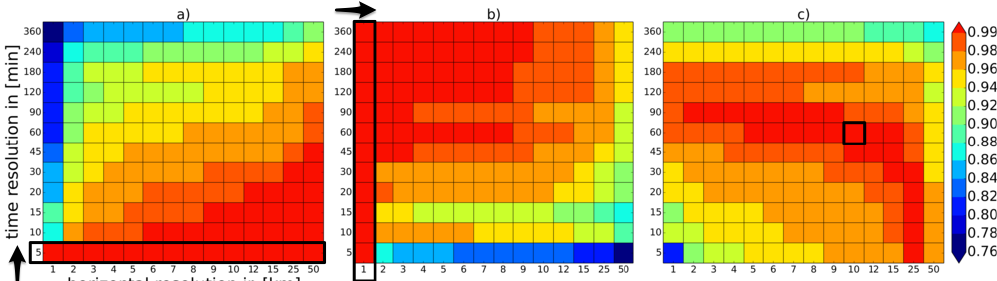
Figure 11. PDF overlap of stratiform precipitation intensity; otherwise similar to Fig.